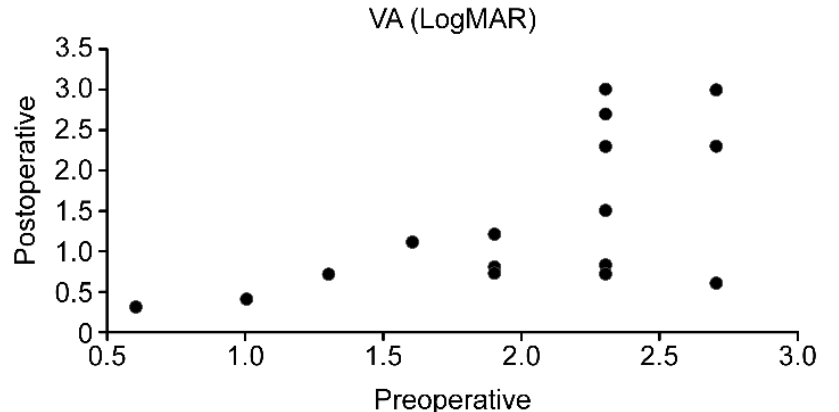
Figure 1. Comparison of visual acuity pre- and postoperatively. Table 1. Mean visual acuity of the traumatic and postinfectious groups. All Patients